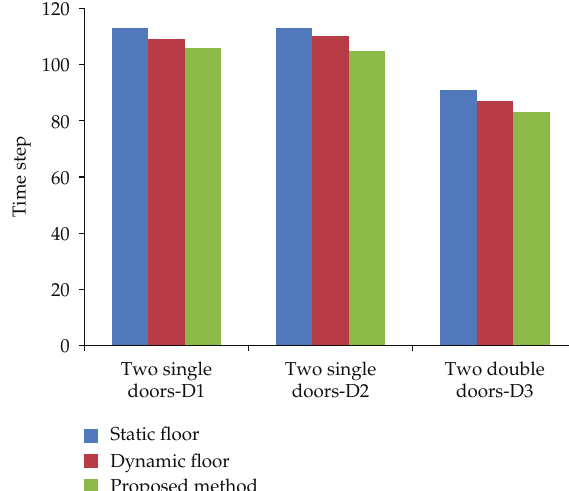
Figure 20: Comparing evacuation time (cid:2) in time steps (cid:3) for the static, dynamic, and proposed models for di ff erent types of doors.